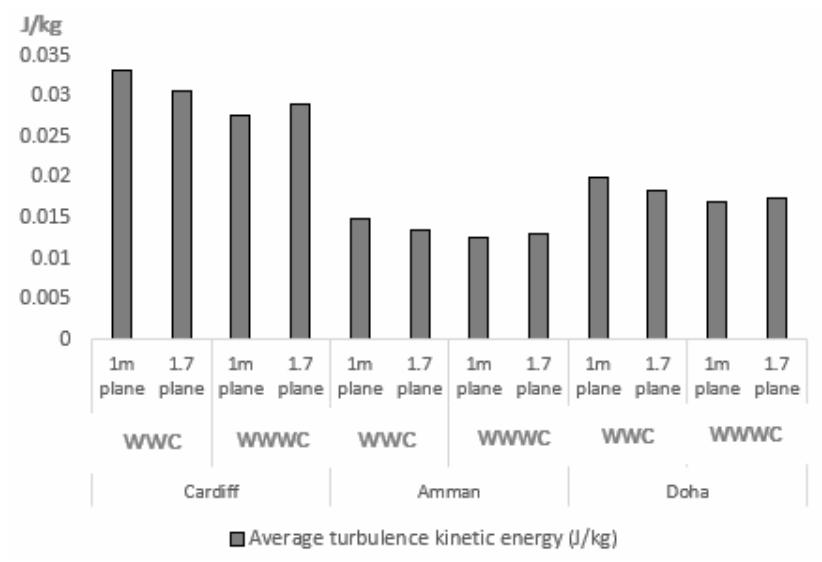
Figure 17. Average turbulence kinetic energy of the interior planes (1 m and 1.7 m) using a Window- WindCatcher (WWC) and Without Window-WindCatcher (WWWC).